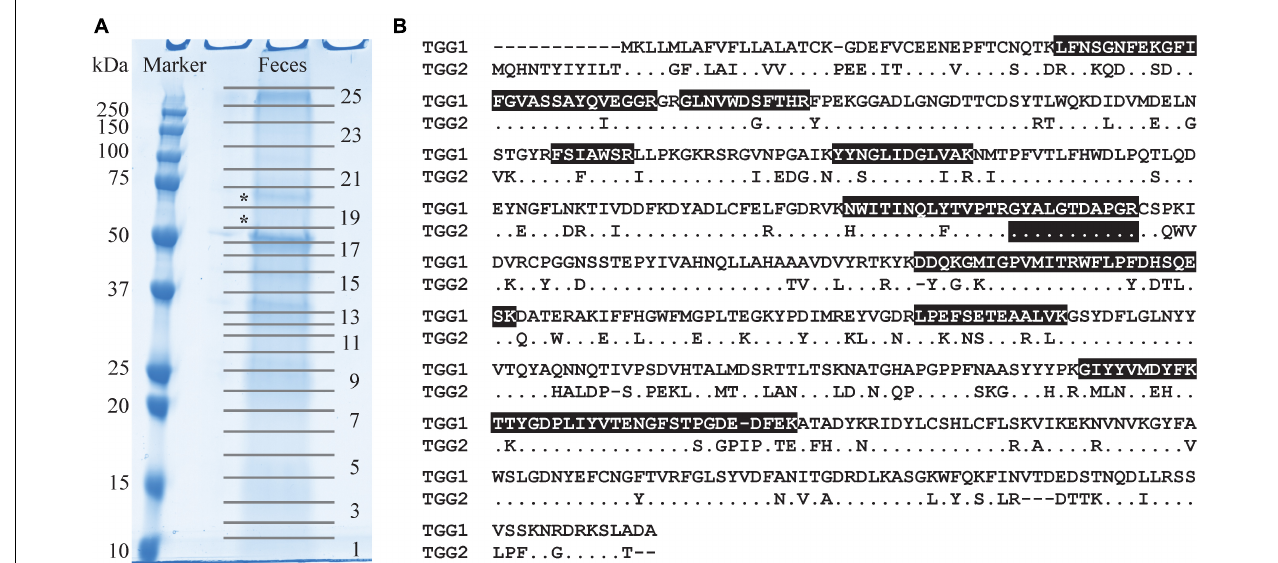
FIGURE 5 | Detection of Arabidopsis myrosinases in the feces of P. armoraciae. (A) One dimensional SDS/PAGE gel of crude feces protein extract. Numbers indicate samples excised for proteomic analysis by nano-UPLC-MS E (only odd numbers are shown). TGG1-derived peptides were detected in bands marked with asterisks (*). (B) Amino acid sequence alignment of the Arabidopsis myrosinases TGG1 (AT5G26000.1) and TGG2 (AT5G25980.2). Identical amino acids in the TGG2-sequence are represented by a dot. Peptides highlighted with black background were detected by nano-UPLC-MS E ( Supplementary Table 6 ). Only one detected peptide matched both TGG1 and